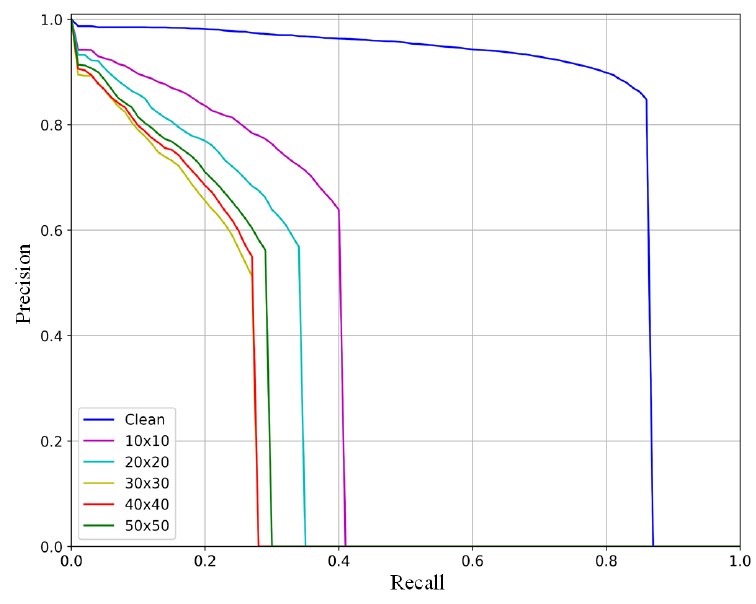
Figure 3. PR curves of our adversarial patches of different sizes compared with clean images (Clean).